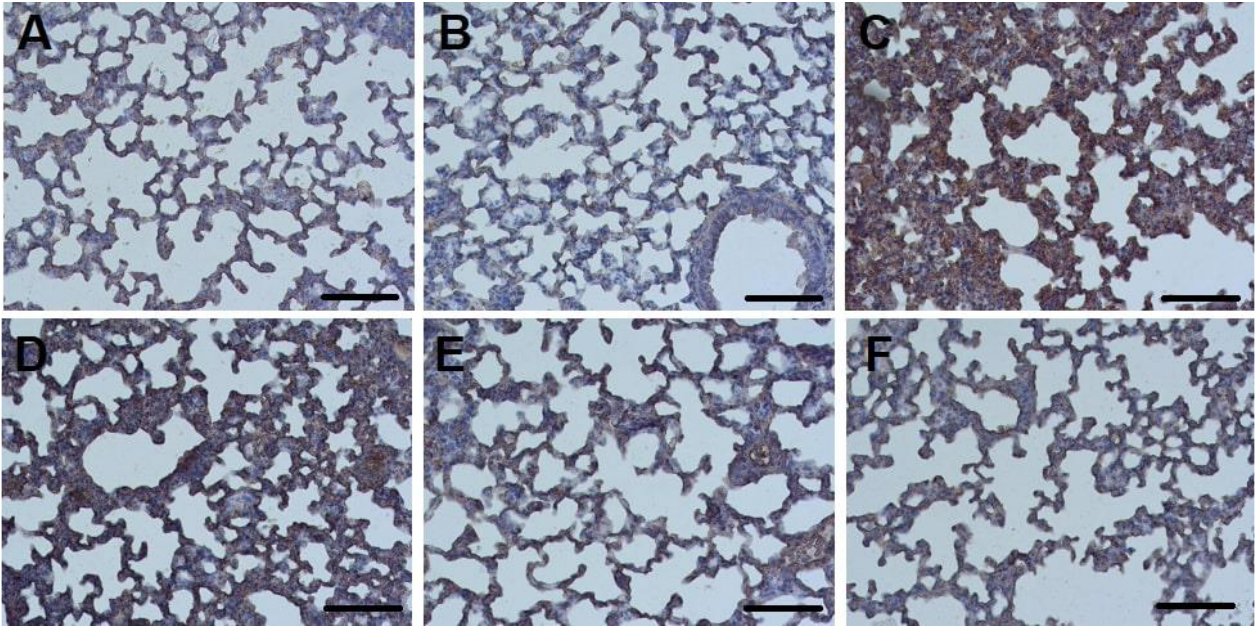
Figure 3. Sections of lung tissue in the Control + nSta ( A ), Control intact ( B ), and ALI groups ( C ) and in the ALI groups treatment with nSta inhalation (( D ) — 0.2 mg/kg, ( E ) — 0.4 mg/kg, ( F ) — 0.6 mg/kg), stained with anti-fibrinogen antibodies. Cell nuclei are stained with hematoxylin. Magnification × 20. Scale —100 μm .